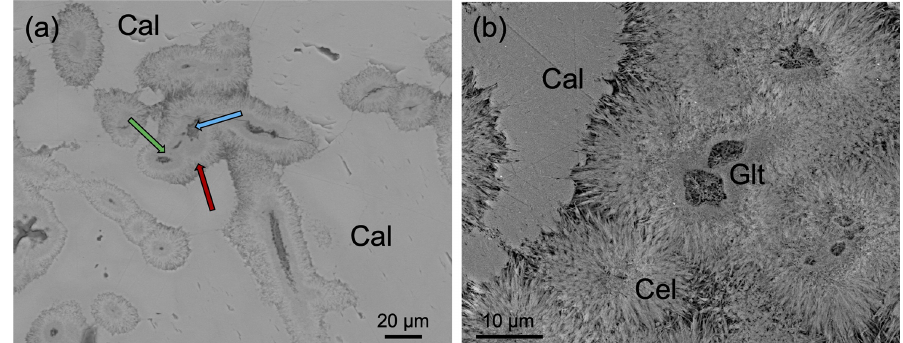
Figure 3. BSE images of the green micas surrounded by calcite: (a) view of different sections of filaments in which the inner voids (blue arrow), surrounded by a dark grey material (glauconite, green arrow), and the external one composed of celadonite (red arrow) can be differentiated; (b) detail of the green micas showing the radial disposition of the celadonite lath-like crystals that make up the outer coating. Cal – calcite; Cel – celadonite; Glt – glauconite. Table 1. Structural formulae for green micas normalized to six cations (IV + VI) based on WDX data (EMPA analyses). Fe distributed as Fe 2 + and Fe 2 + by charge